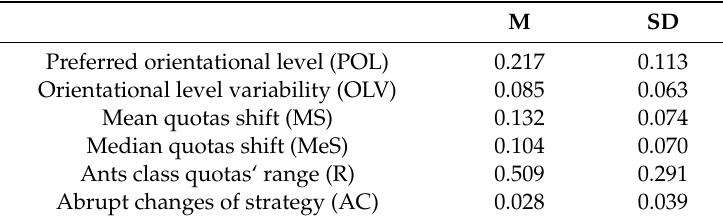
Table A1. Descriptive statistics for the parameters of the strategies.